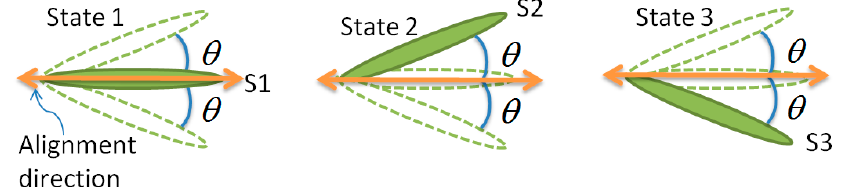
Figure 1. Top view to illustrate the FLC molecule orientation, state 1 represents the no-applied-electric-field state, state 2 and 3 represent the two different states with different electric field polarities.